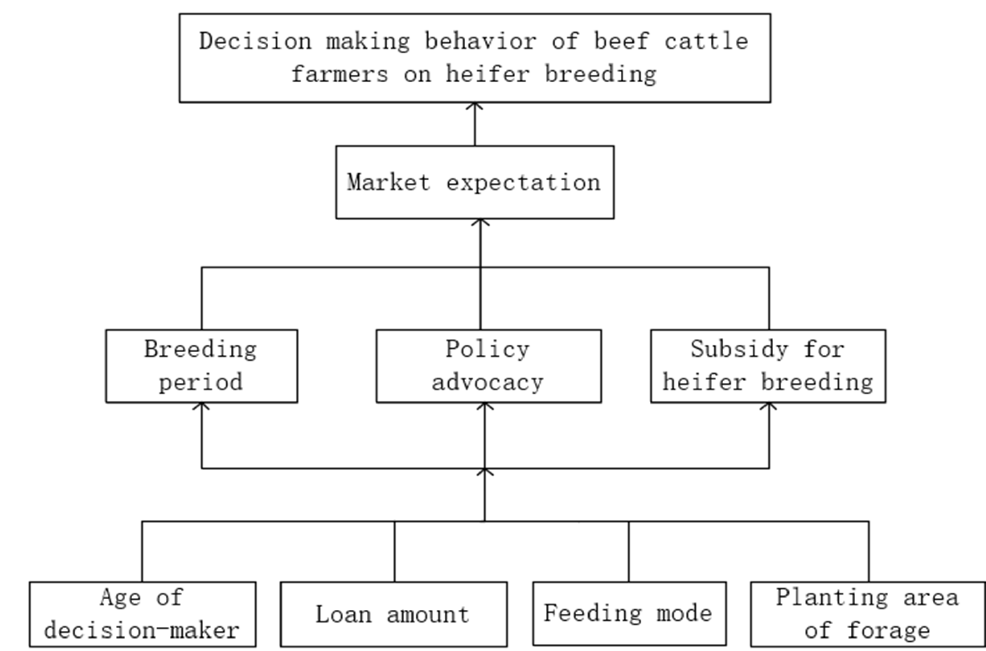
Figure 2. Hierarchical structure diagram of influencing factors.